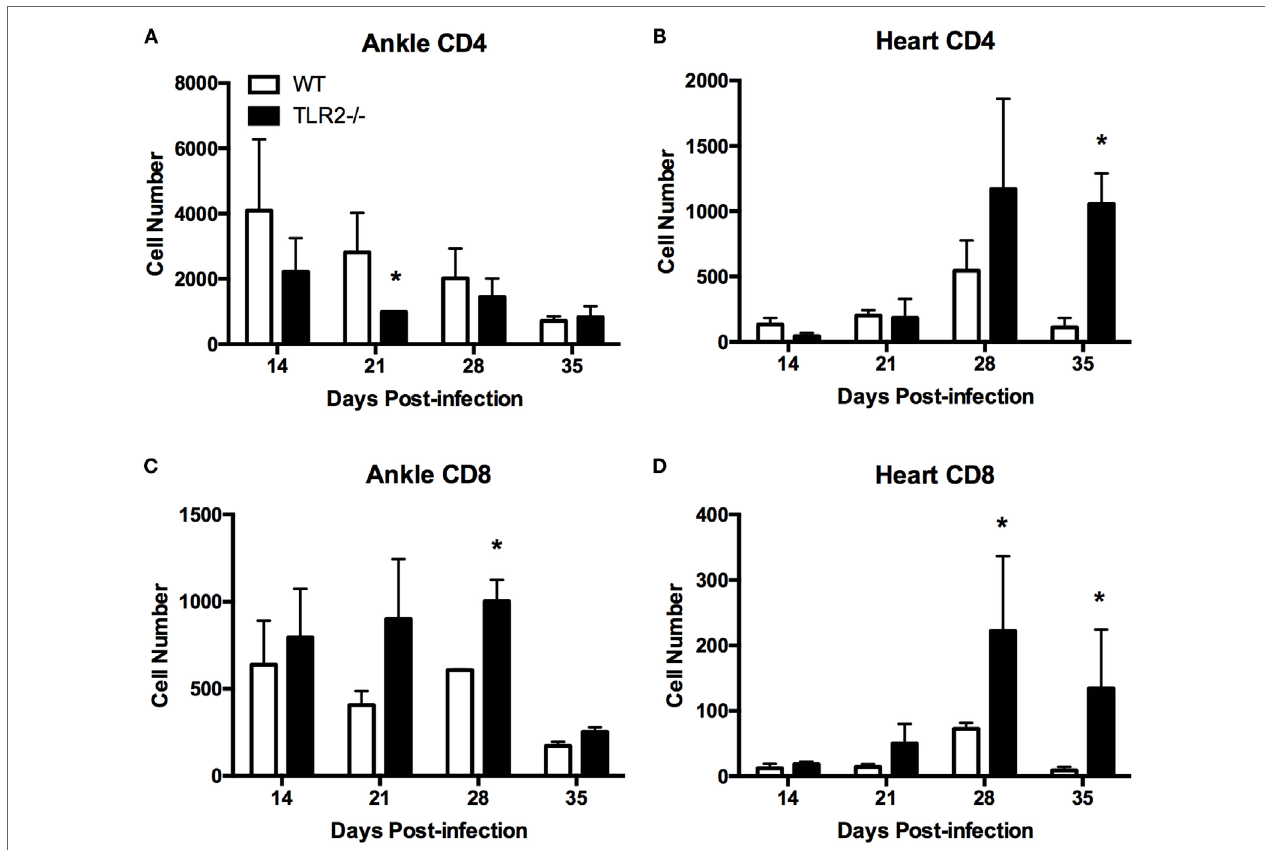
FigUre 2 | T cell subsets in infected ankle and heart tissue . WT and TLR2 − / − mice were infected with B. burgdorferi and three mice from each strain sacrificed at the indicated time points. T cell subsets in ankle (a,c) and heart (B,D) tissue were characterized for CD4 (a,B) , CD8 (c,D) by flow cytometry. Data are representative of two separate experiments. Bars represent means + SD. * p > 0.05 compared to WT control from same time